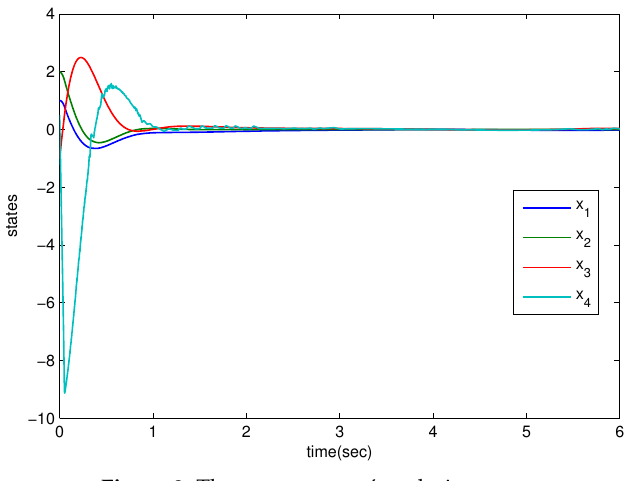
Figure 8. The system states’ evolution curves.